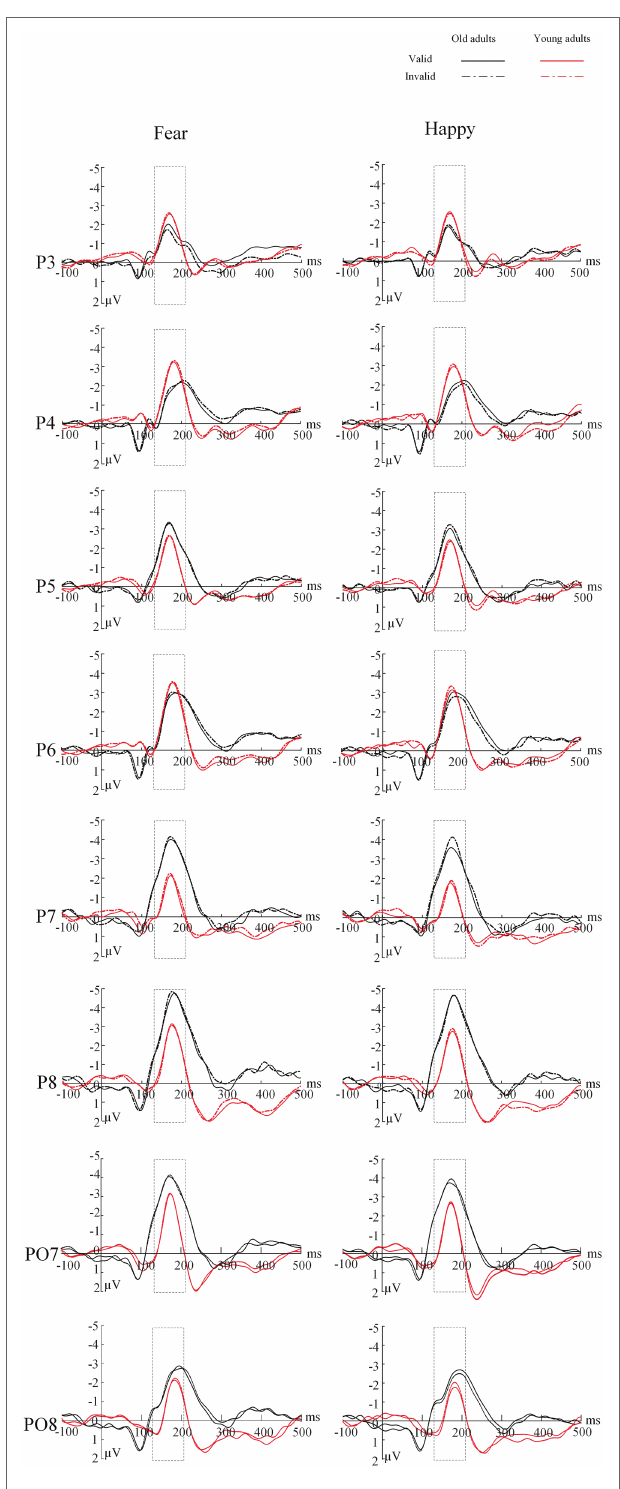
FIGURE 4 | Grand average ERP of the N170 component for each group at channel P3/P4, P5/P6, P7/P8 and PO7/PO8. Solid lines = valid trials, dotted lines = invalid trials, black = older group, red = young group. The rectangular box represents the selected time